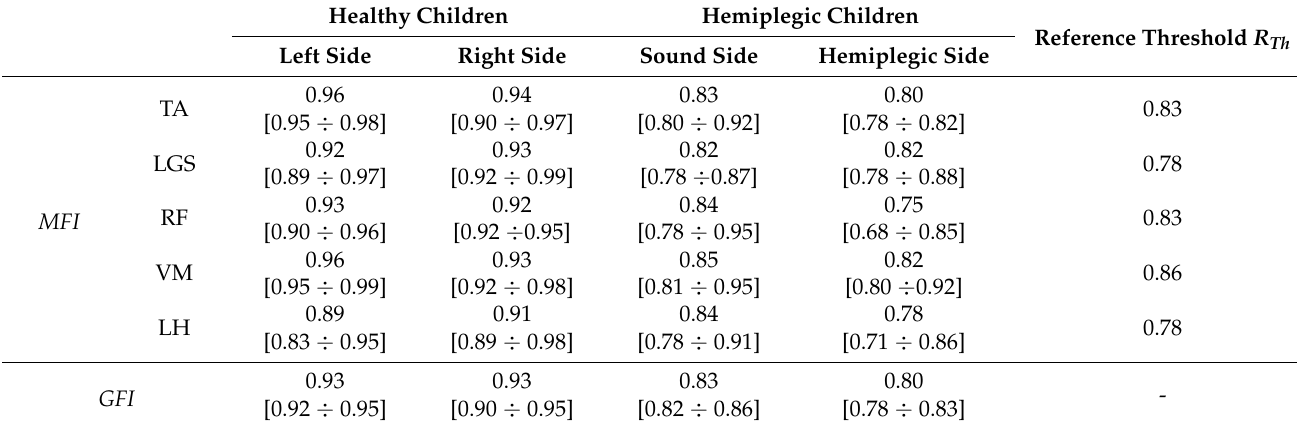
Table 2. MFI and GFI values for the test groups (mean value [first and third quartile]) and the reference thresholds.